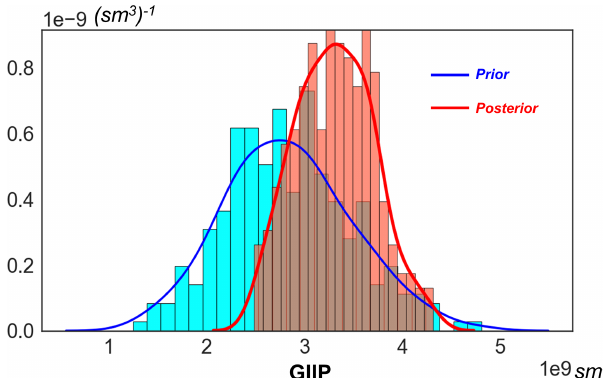
Figure 21. The prior and posterior prediction of GIIP.